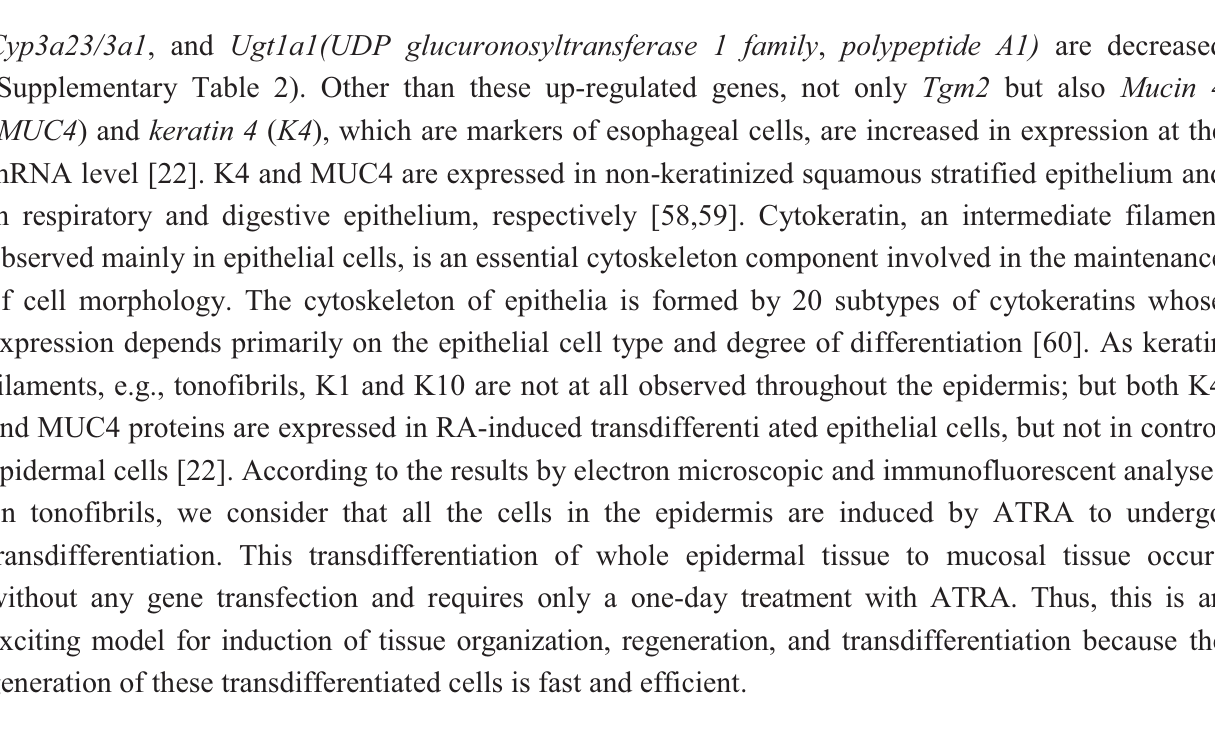
Table 1. List of representative genes up-regulated in 16E rat embryonic dorsal skin